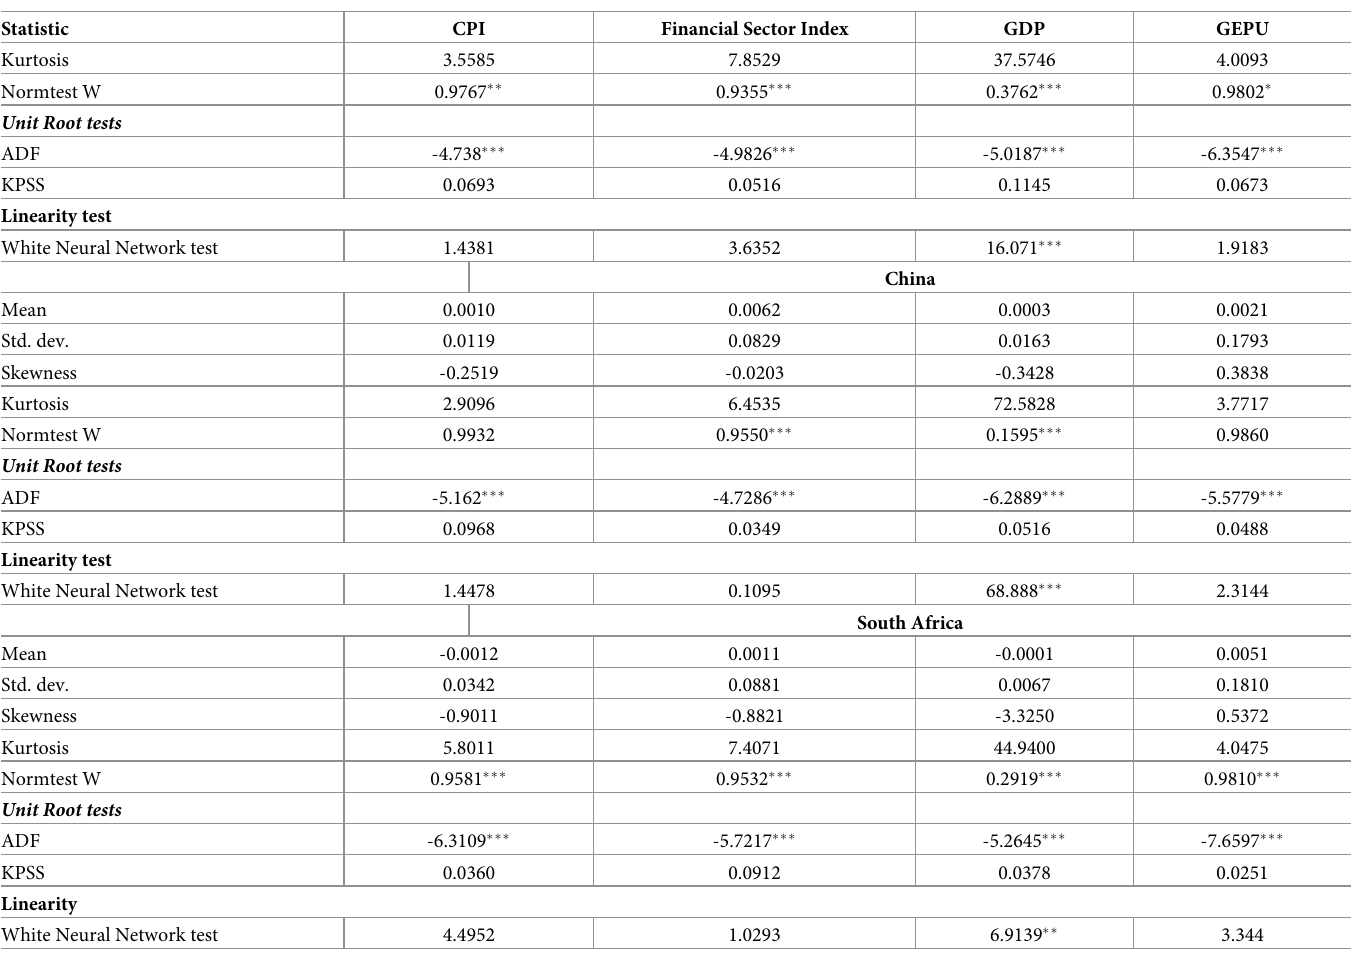
gross domestic product (GDP) are respectively in-phase (movement in identical direction) and antiphase (movements in the reverse direction) to ensure the smooth interpretation of the results. Right-pointing arrows upwards and left-pointing arrows downwards mean that the first variable leads, while the left-pointing arrows upwards and the right-pointing arrows downwards mean that the second variable leads. The intensity of the interdependence between the paired series is indicated by the surface colour and the colour pallet is represented. The red (warm) colour signifies parts that have major interactions, while the blue (cold) colour shows a lower series correlation. The cone of influence (COI) within the bivariate plots indicates the region where interpretation of the wavelet becomes important. The results outside the COI may be distorted or unreliable because of the end-points influence of finite length signals. Fig 2 presents the comovements between RFSI and GDP via the bivariate technique as well as the influence of GEPU on the nexus between RFSI and GDP through the partial wavelet coherence each for BRICS economies. In general, the combined influence of RFSI and GDP appears more dominating for BRICS economies except for China and possibly India from